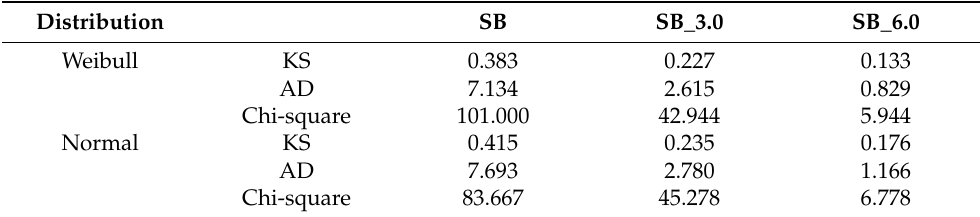
Table 2. Various structural properties of the distribution change of pH during the fermentation of soy beverages with acai